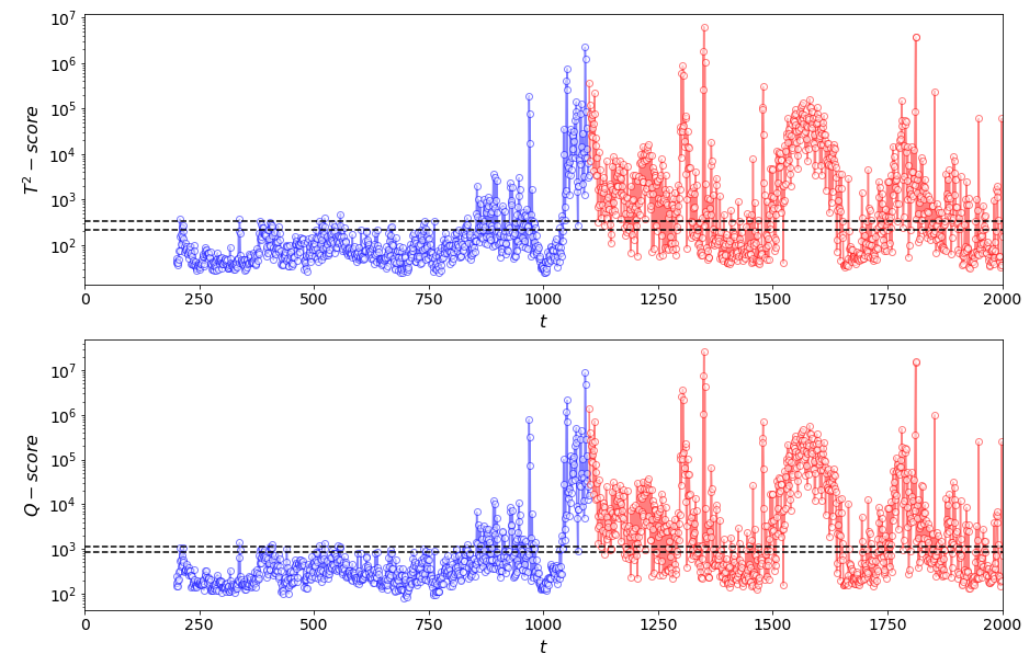
Figure 19. 𝑇 2 ( top ) and Q ( bottom ) process monitoring charts of AG mill power draw for a window length of 200 time steps using Method I. NOC data are shown in blue and test (fault) data in red.